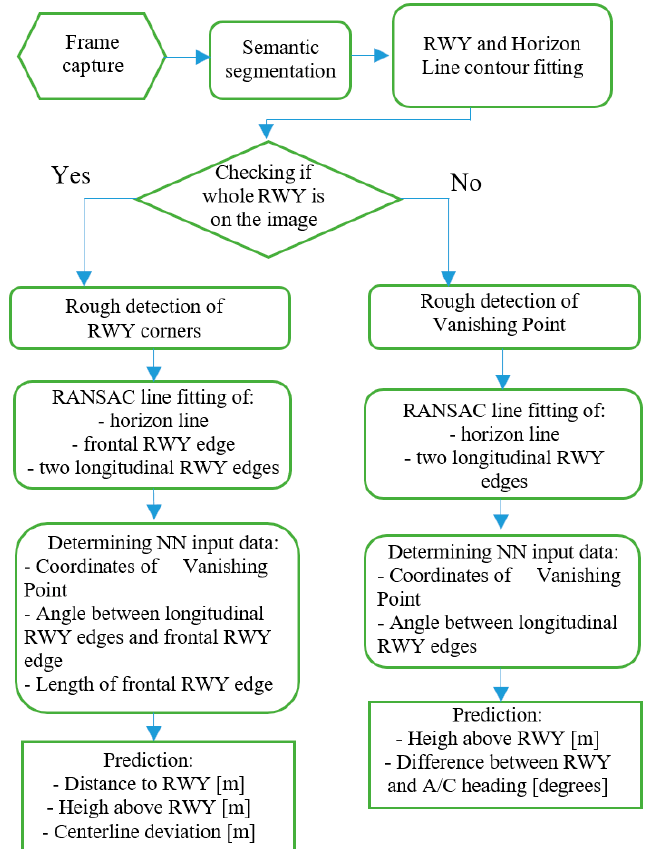
Figure 1. Operation of the system.